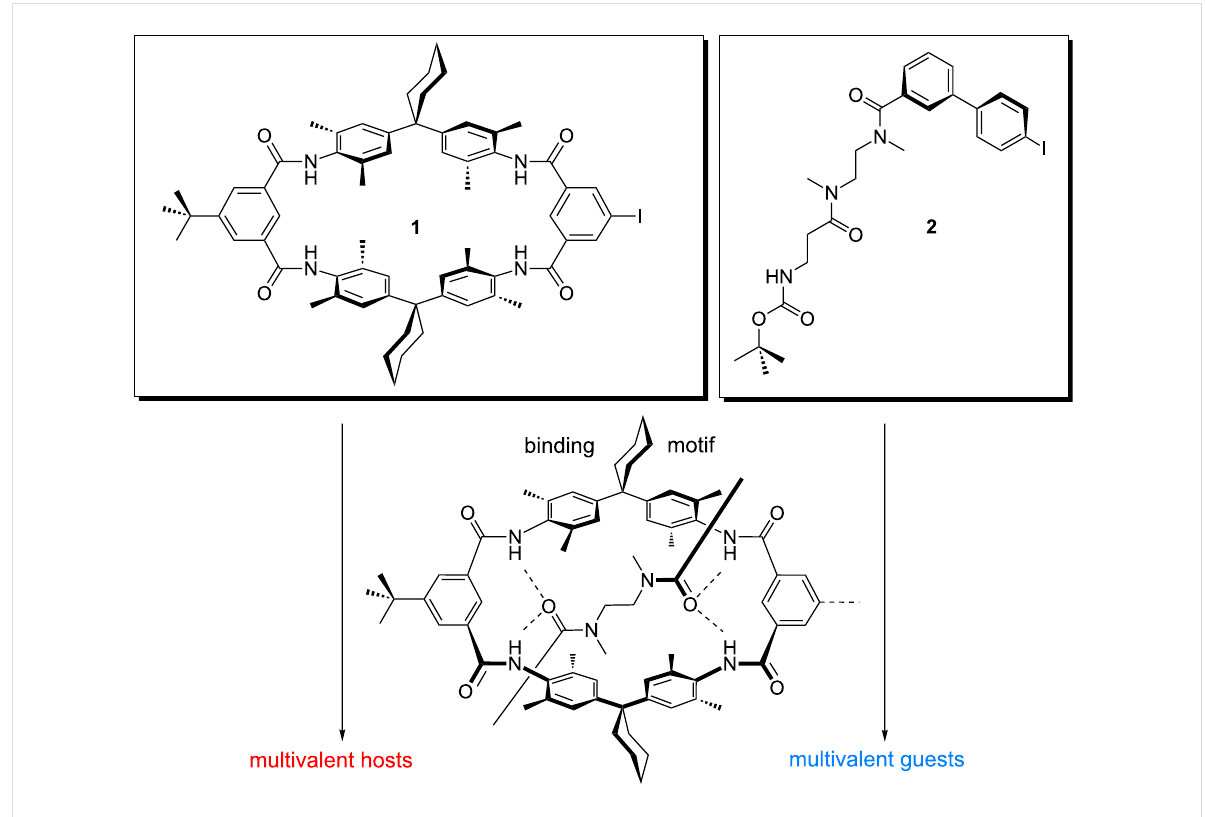
Figure 1: Hunter/Vögtle-type tetralactam macrocycle 1 bearing an iodo substituent at one of the isophthaloyl groups, and the diamide axle piece 2 . The iodoaryl groups in both building blocks are suitable for Sonogashira cross-coupling reactions. Therefore, these monovalent precursors can be connected to different suitable spacers so that a "toolbox" of multivalent hosts and guests can be synthesized convergently. The center shows the binding motif, which connects the axle and wheel by four N–H···O hydrogen